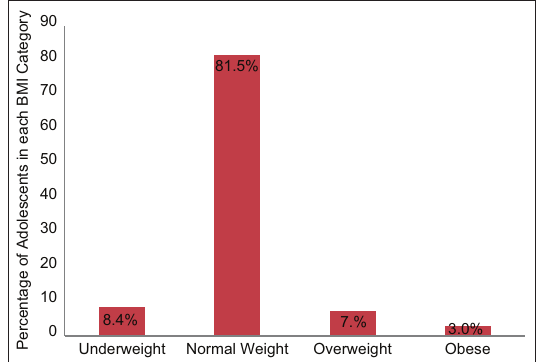
Figure 1 : Nutritional status of secondary-school adolescents in Lagos State (Underweight: BMI<18.5kg/m 2 ; Normal Weight: BMI= 18.5- 24.9 kg/m 2 ; Pre-obesity: BMI=25.0–29.9kg/m 2 ; Obesity class I: BMI=30.0- 34.9 kg/m 2 ; Obesity class II: BMI= 35.0-39.9 kg/m 2 ; Obesity class III: BMI>=40 kg/m 2 )